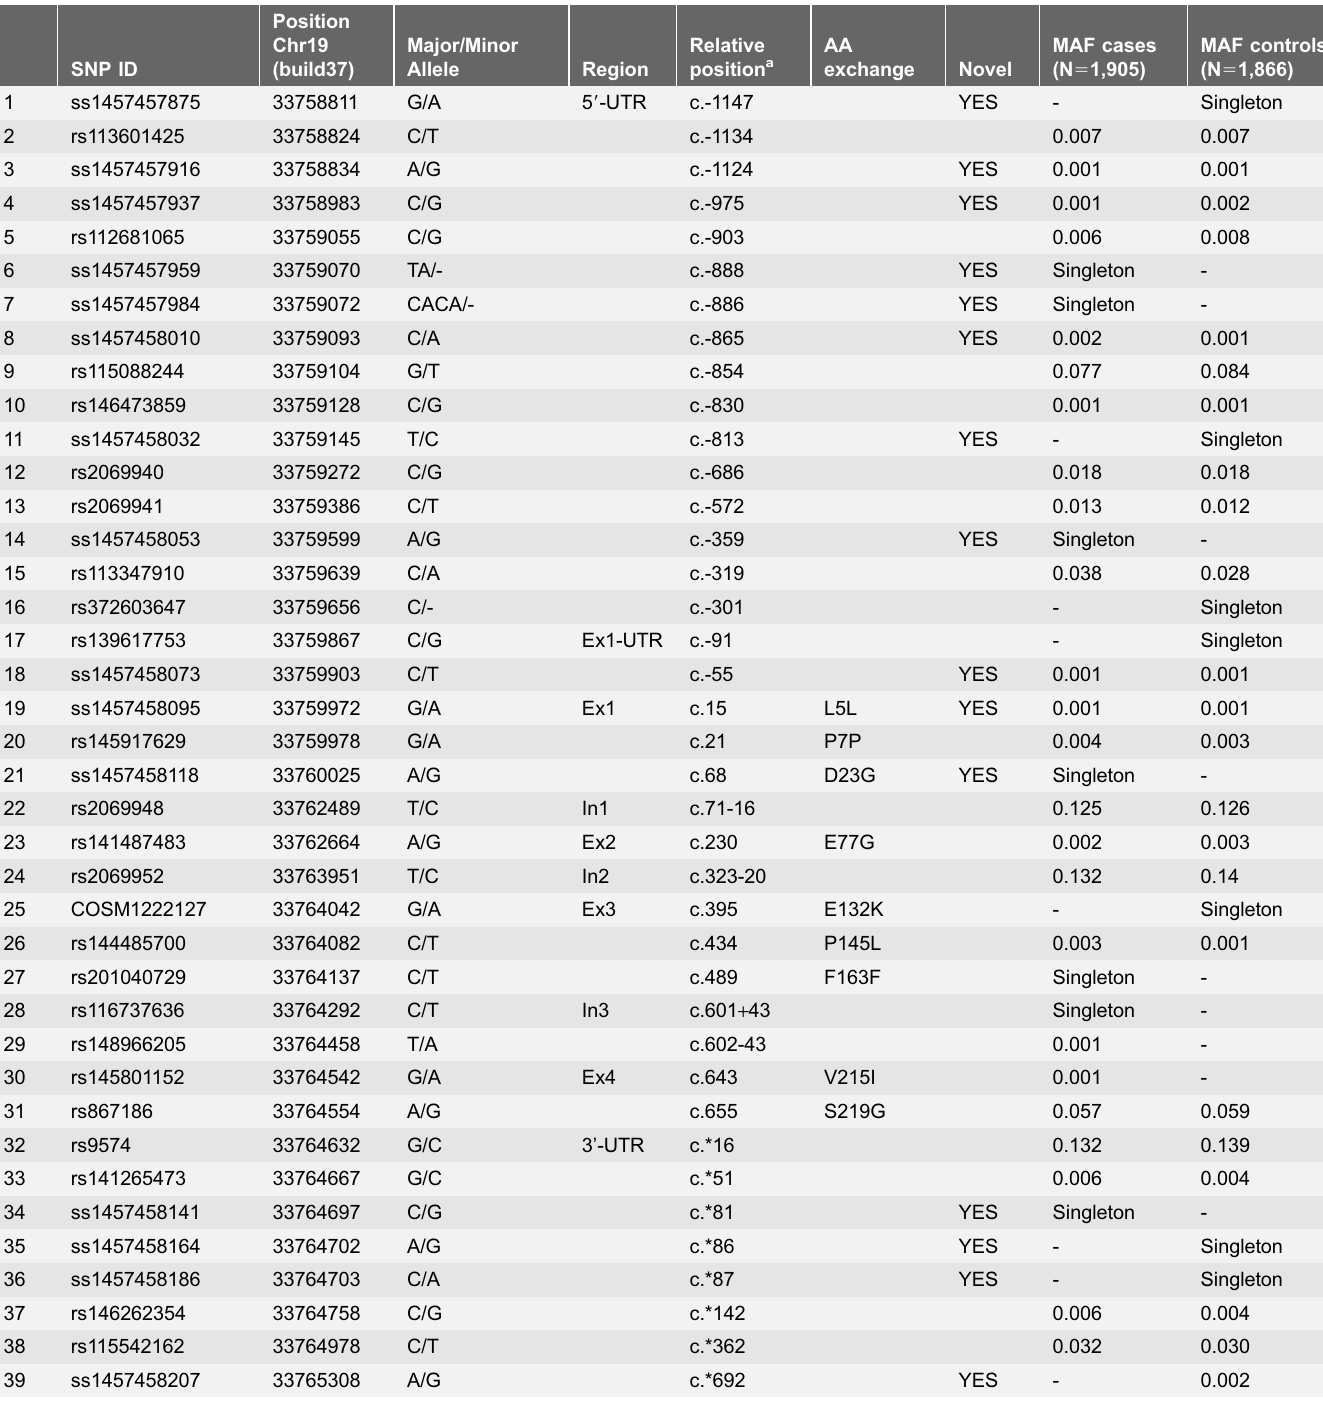
Table 1. Genetic variants in the PROCR gene found in 3,771 Ghanaian